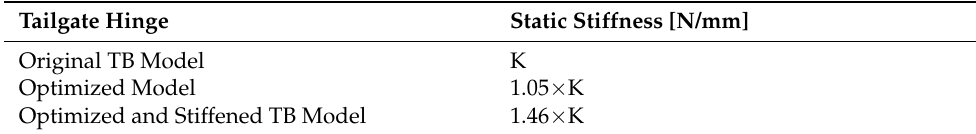
Table 2. Static stiffness of the hinge attachment.